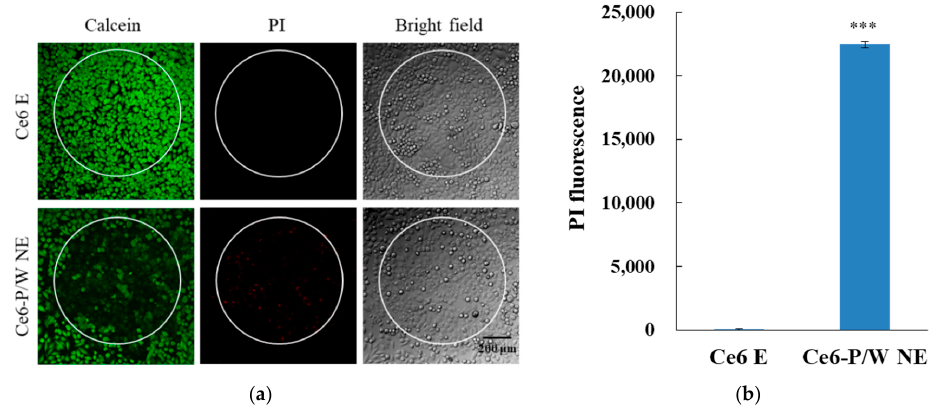
Figure 5. ( a ) Calcein/PI staining and corresponding bright-field images and ( b ) necrosis indicated by PI fluorescence signals of cells treated with Ce6 E or Ce6-P/W NE upon light irradiation (633 nm, 50 mW/cm 2 ) in a hypoxic condition for 105 s. Ce6-P/W NE concentration, 400 μ g/mL. Ce6 concentration, 8 μ g/mL. Green color shows living cells, and red color shows dead cells. The white circle indicates the irradiation area. Data were presented as mean value ± standard deviation. After Levene’s test for equality of variances, Student’s t test was employed for the comparison of mean values. n = 3. ***, p < 0.001. PI, propidium iodide. Ce6 E, chlorin e6 emulsion. Ce6-P/W NE, chlorin e6-perfluoropolyether (PFPE)/water nanoemulsion.